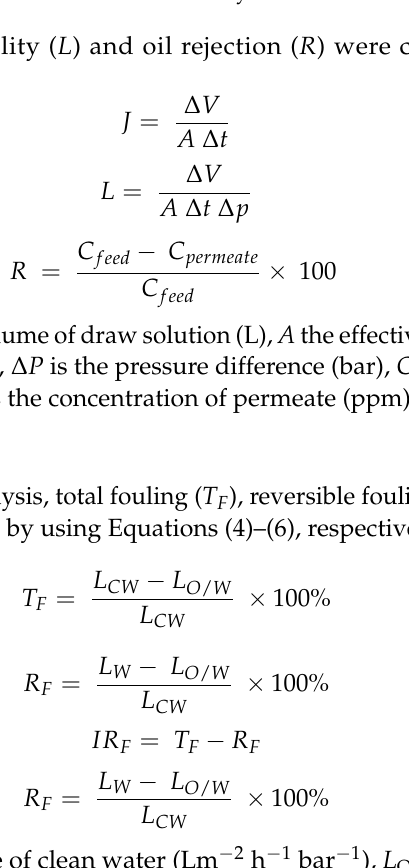
Figure 2. Laboratory setup illustration of the filtration